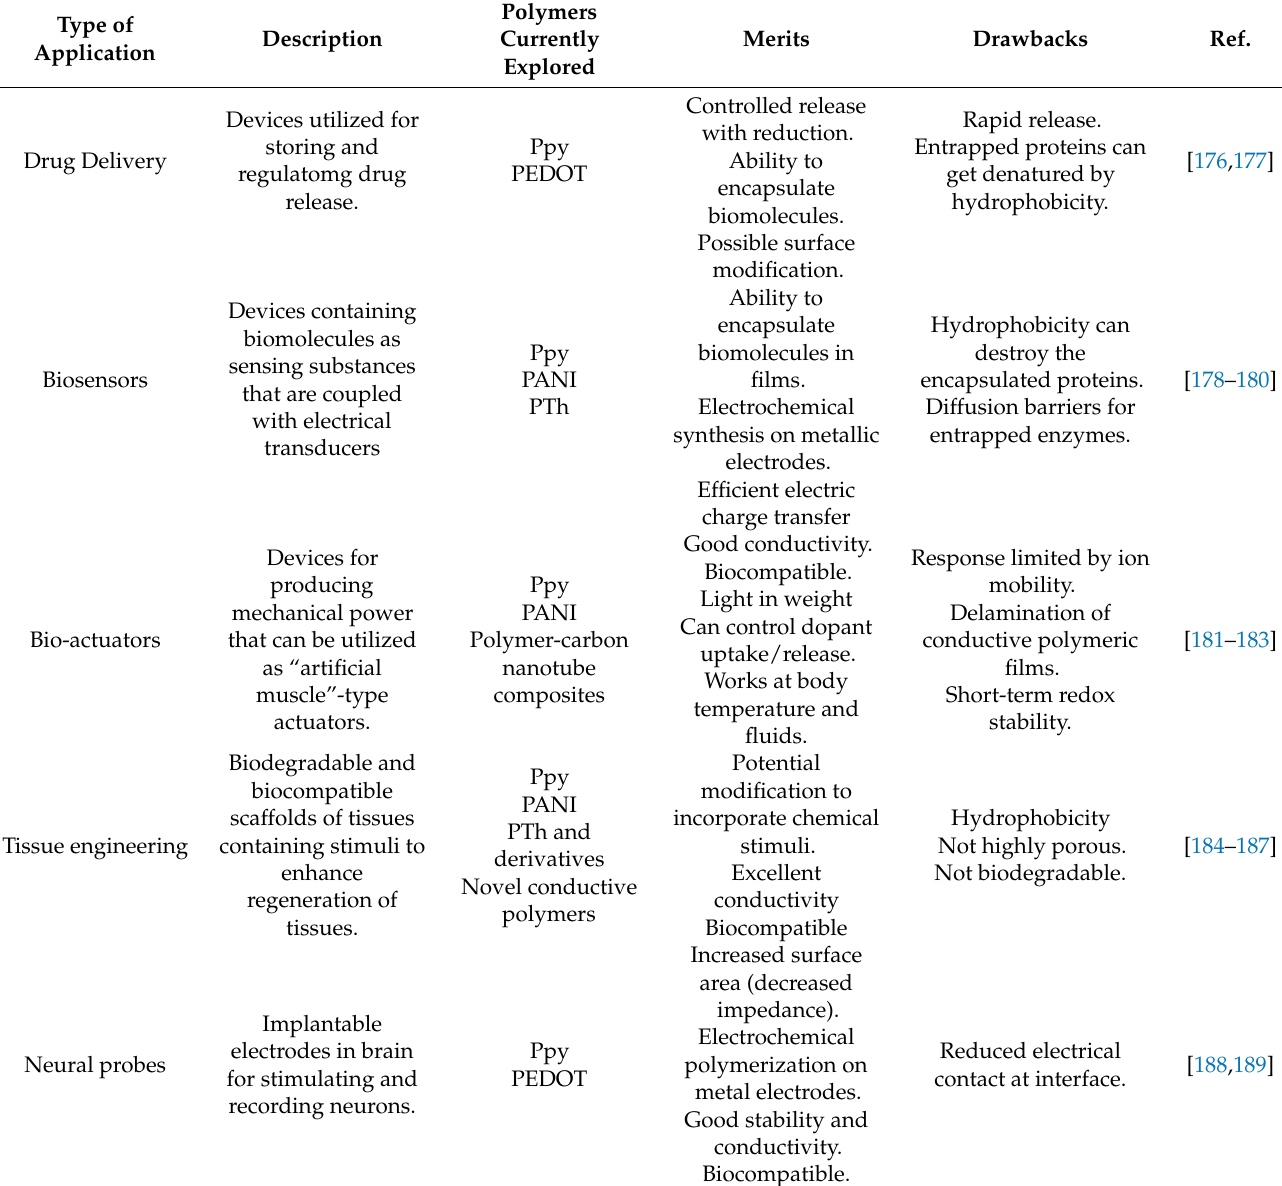
Table 3. Biomedical applications of